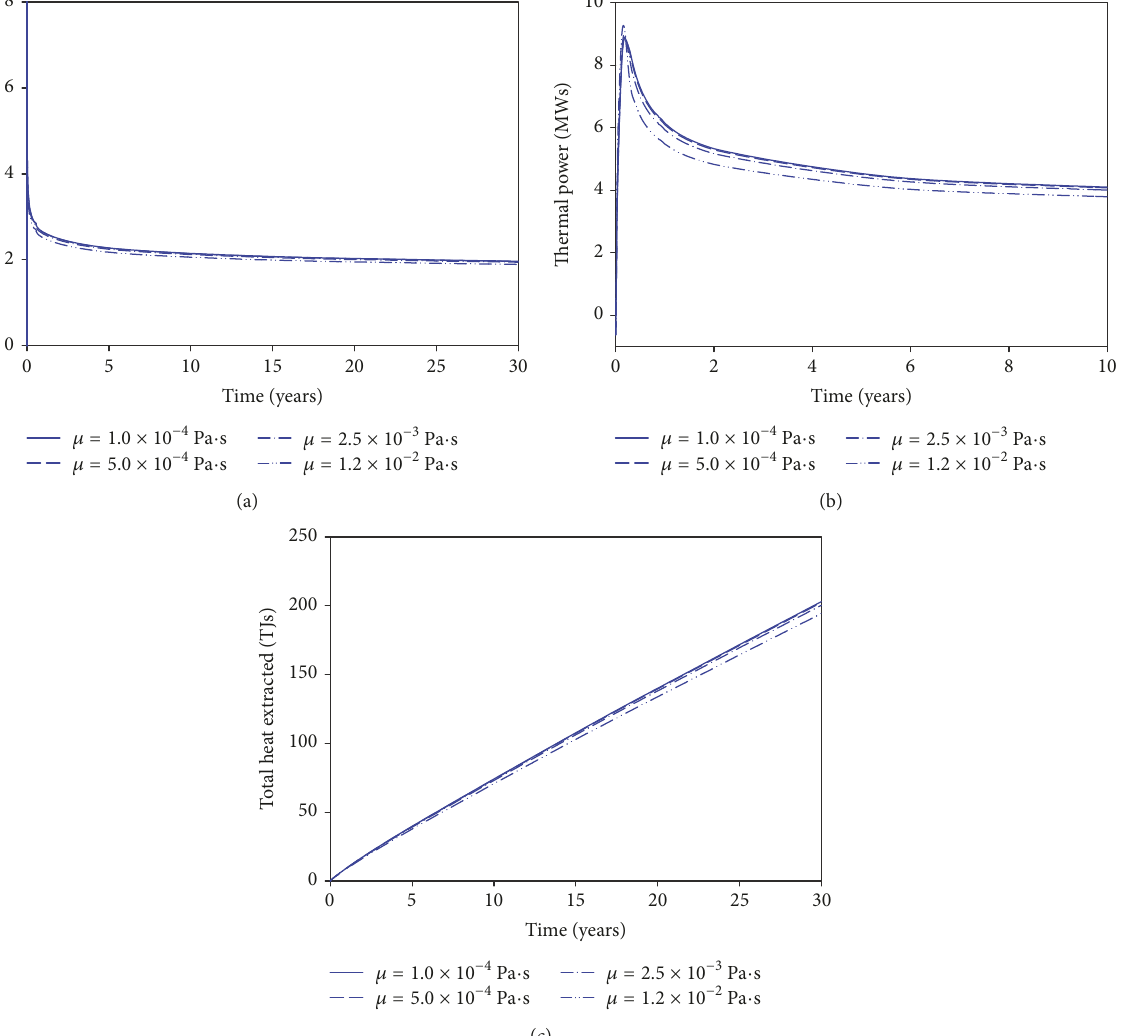
Figure 10: Thermal power and total heat extracted for different fluid viscosities: thermal power (a) for large time and (b) for short time and (c) total heat